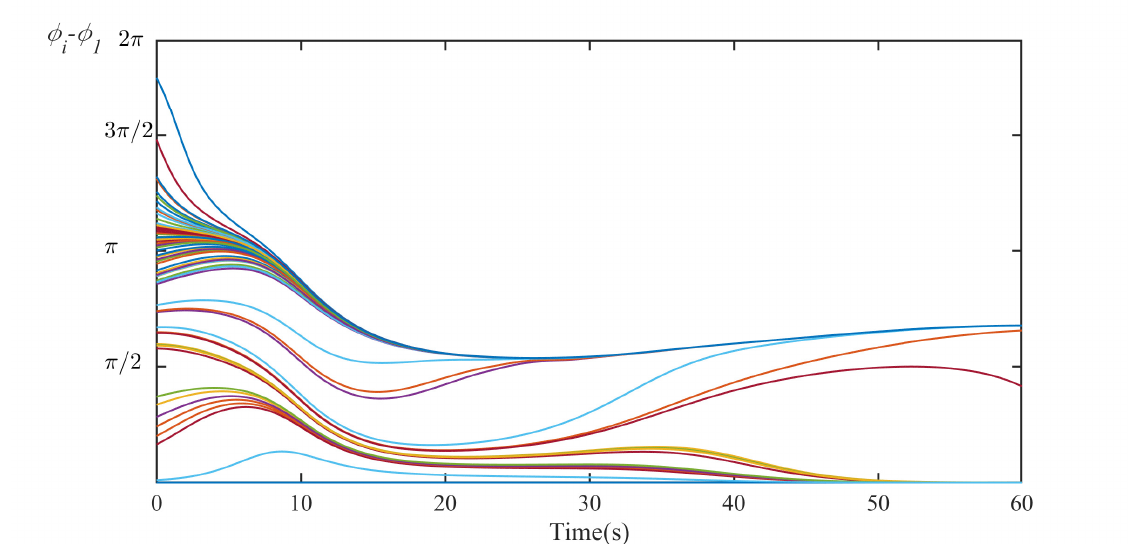
Figure 14. The simulation results are shown for the first individual’s third image using the second individual’s H ij function, which is a unstable cluster partition. Each curve represents the phase difference φ i − φ 1